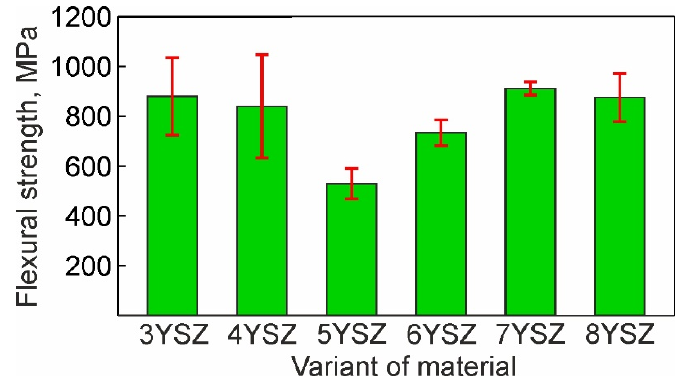
Figure 12. Flexural strength of six studied materials with 3–8% Y 2 O 3 .